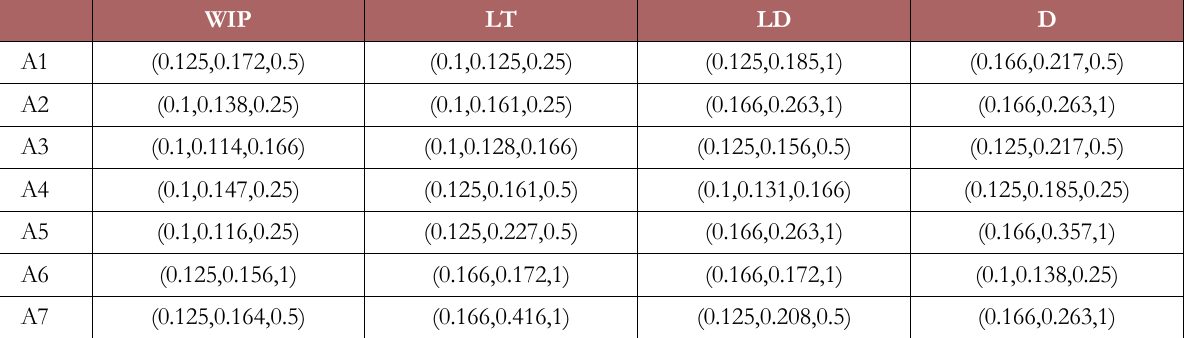
Table 10. Normalized fuzzy decision matrix for solutions